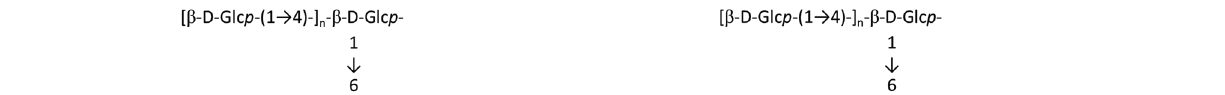
Figure 18. HCLPS-1 ( 84 ) isolated from clam of Hyriopsis cumingii [108].